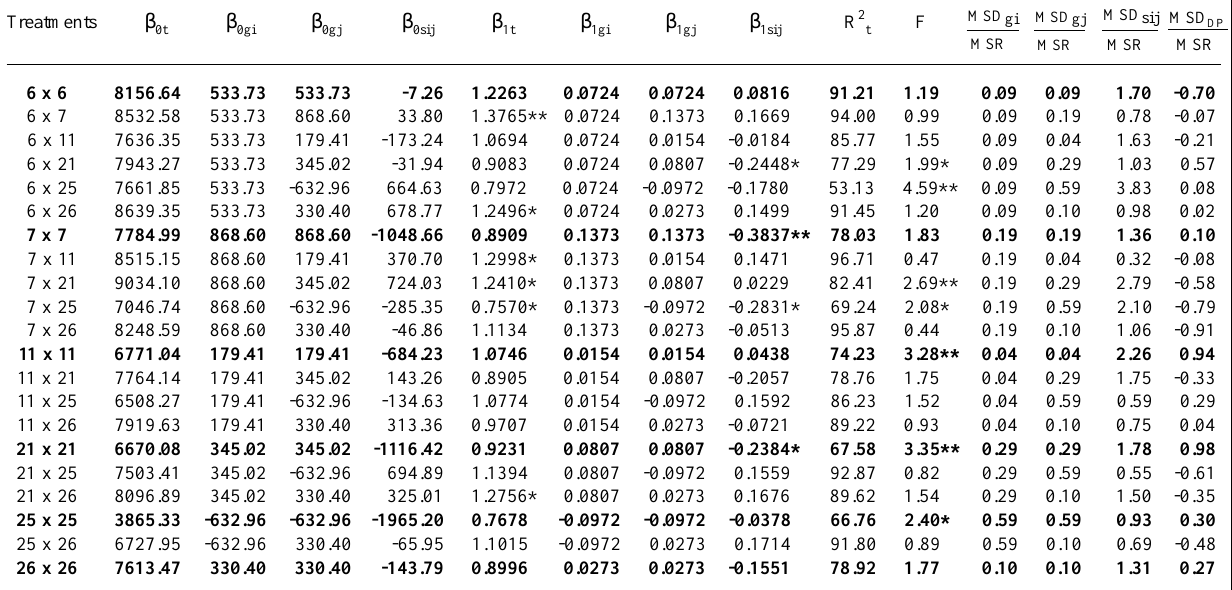
Table I - Adaptability and stability parameters from Eberhart and Russell (1966) and their partitioning by the effects of Griffing’s (1956) general and specific combining effects. Sampling of a diallel among 28 populations and their 378 F1s, assessed in 10 environments.